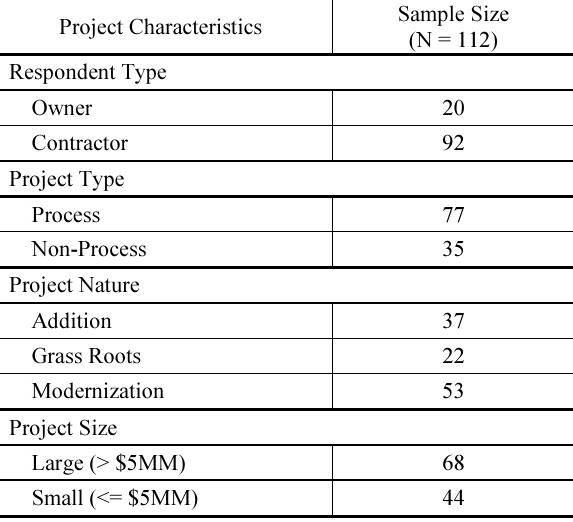
Project Characteristics